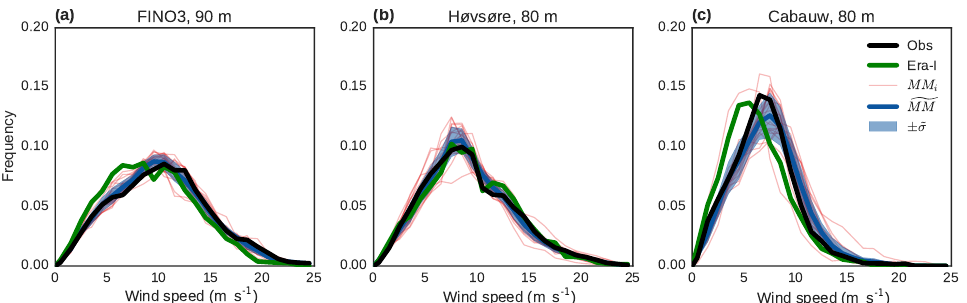
Figure 4. Wind speed distributions at the three sites (FINO3 at 90m, Høvsøre at 80m, and Cabauw at 80m) for the observations (black), the ERA-Interim data set (green), the mesoscale models MM i (red), and the inter-model mean (blue line) and its standard deviation g MM ± e σ (blue shade).